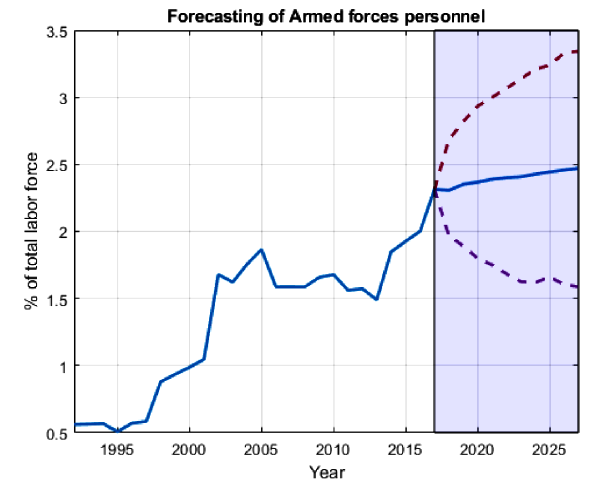
Figure 3. History and forecasting of Armed Forces personnel (source: authors’ calculation)